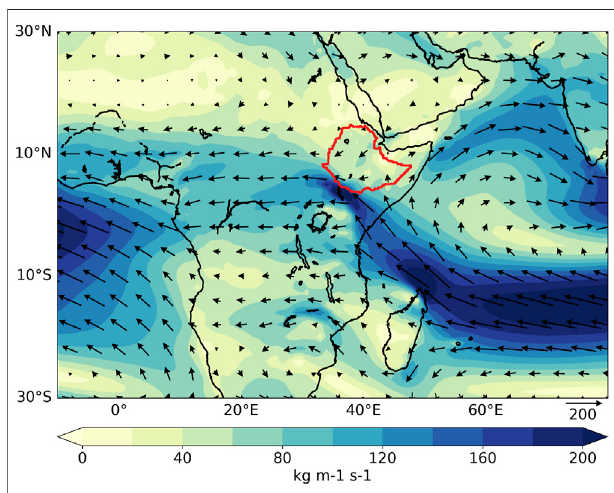
FIGURE 5 | Average pattern and direction of the IVT (kg m − 1 s − 1 ). Period: 1980 – 2018. The borders of Ethiopia are delimited in red.